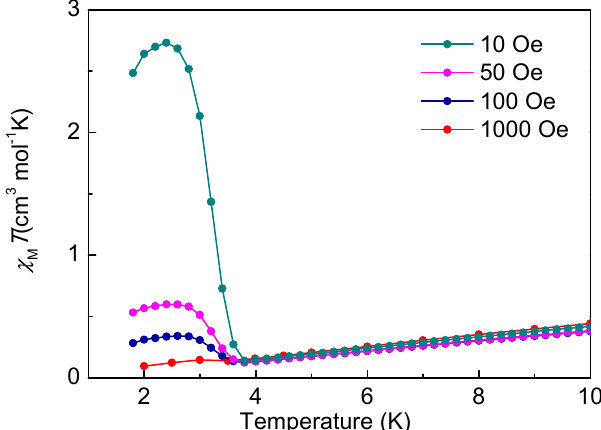
Figure 6. Plots of χ M T vs. T of compound 1 measured under different external fields.